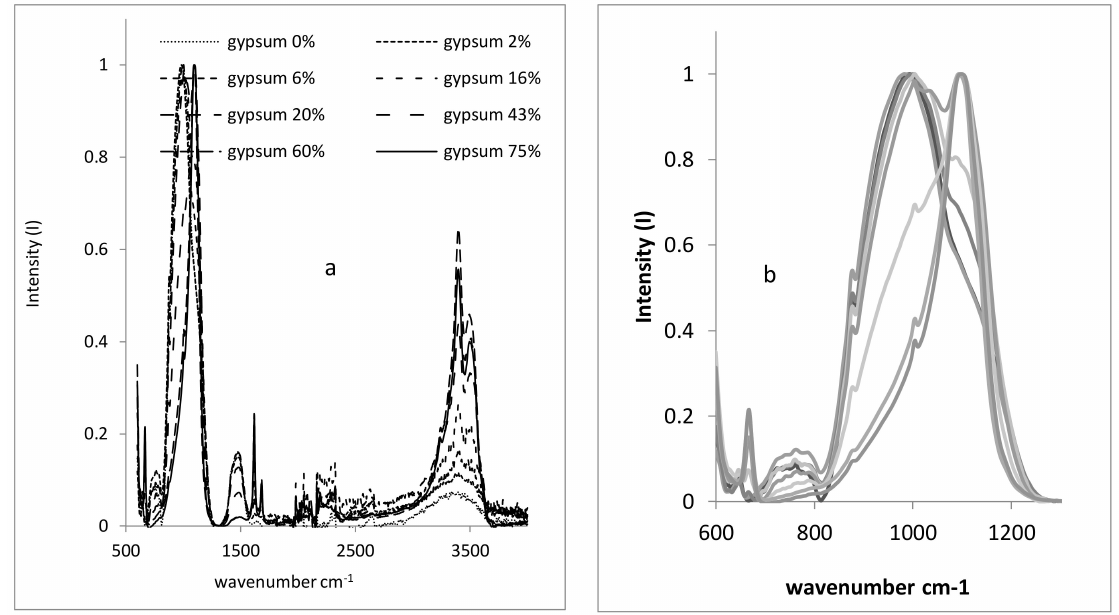
Figure 2. FTIR spectra of several clay–gypsum mixtures (% weight). Total spectrum ( a ), overlapped bands silicate–sulphate ( b